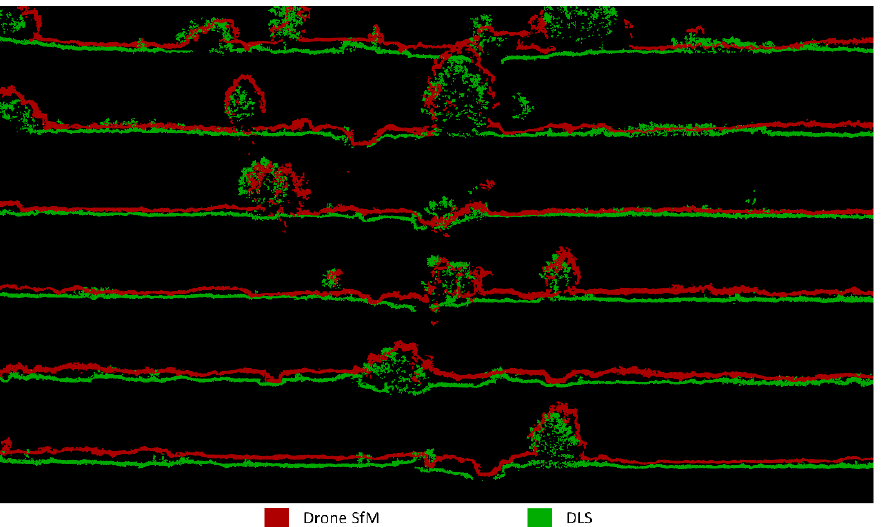
Figure 10. Cross-sections from StREAM Lab showing the differences between SfM and DLS point clouds. point